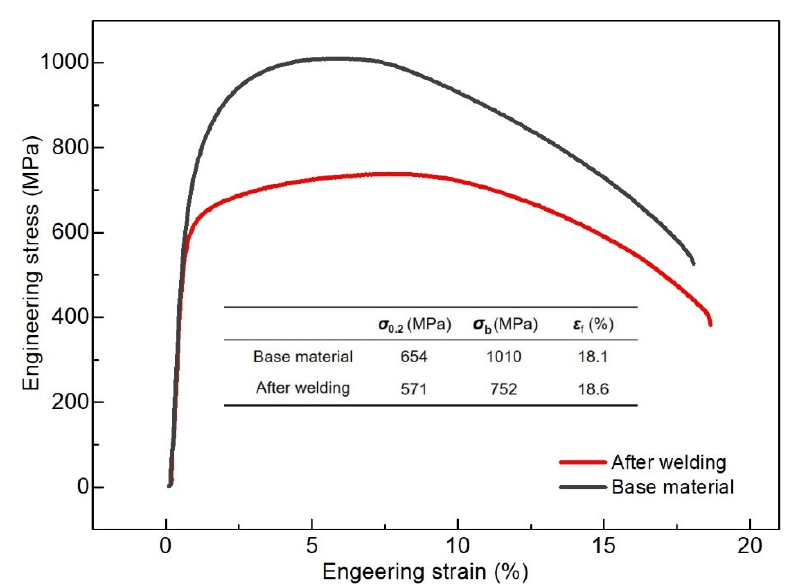
Figure 4. Tensile engineering stress–strain curves of the base metal and the materials after welding. Note that the position of the tensile test sample for materials after welding is indicated in Figure 1b.